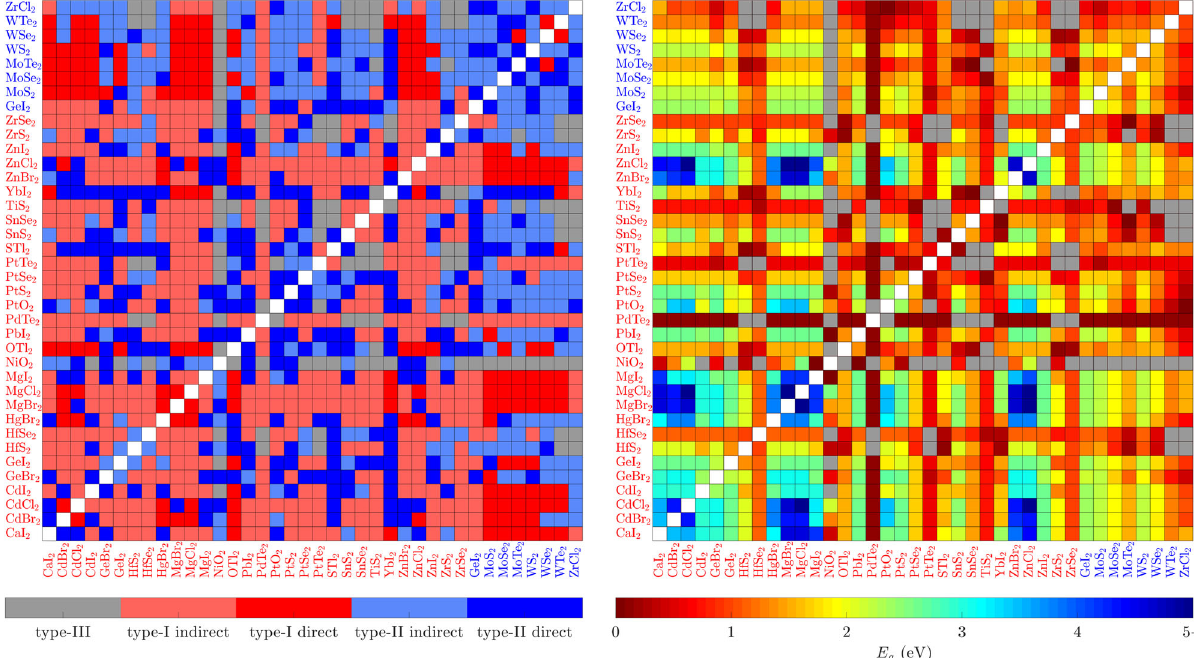
Fig. 7 Summary of all the possible vdWHs made with 38 ML building blocks. MLs written in red have 1T structure, while those in blue are 2H. a The band-alignment type, with color code shown on the bottom (the diagonal is left empty). b The actual value of the band gaps as a heat